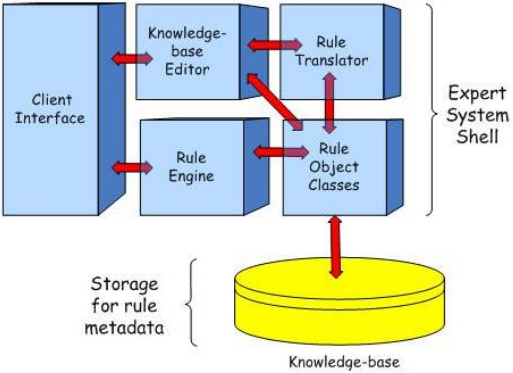
Figure 4. Expert system architecture.